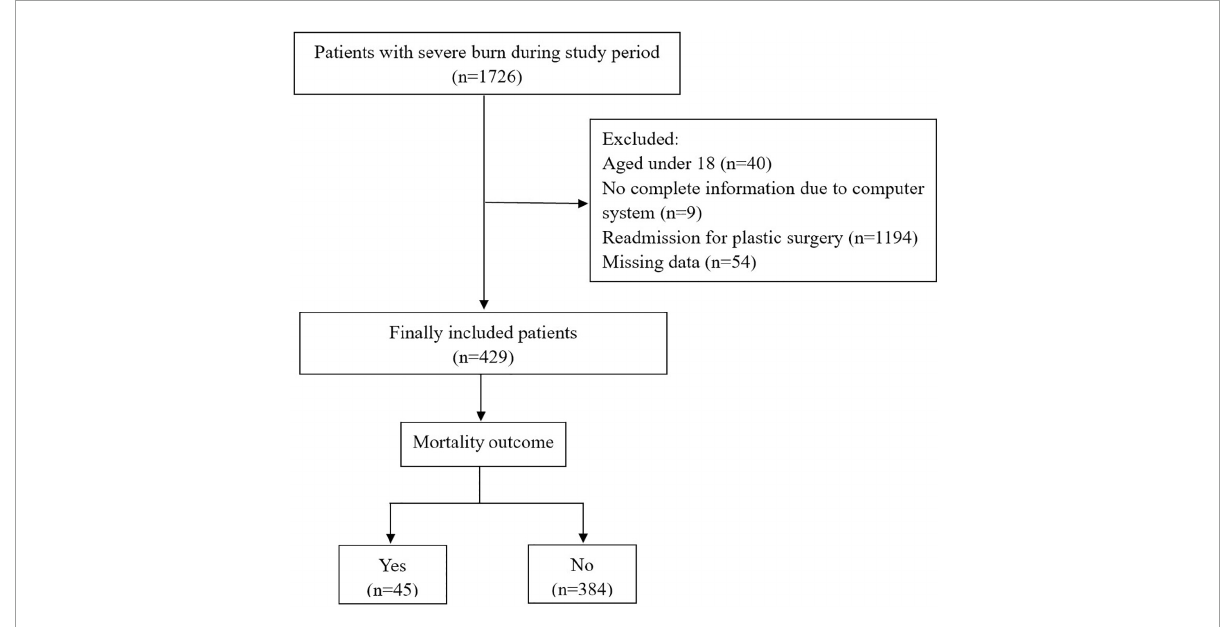
FIGURE1 Flow diagram of study